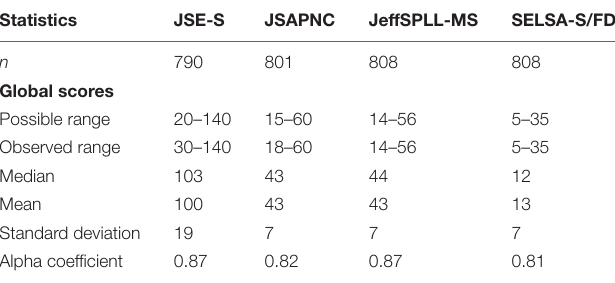
TABLE 1 | Descriptive analysis of the measures of empathy, teamwork, lifelong learning, and family loneliness. Statistics